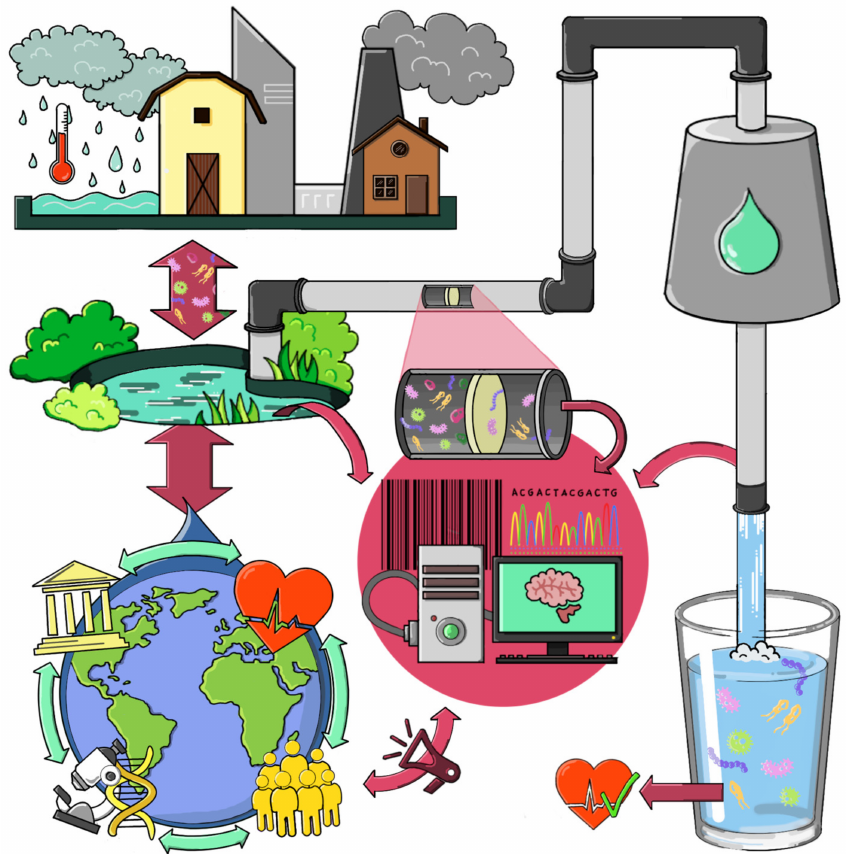
Figure 2. The journey of drinking water source and its microbial communities across drinking water treatment and distribution can be deciphered through omic approaches. Drinking water quality can be preserved and improved thanks to microbiome-based research, and this has multiple effects on human wellbeing, society, science, and the Earth as a whole. Bi-directional arrows highlight the mutual effect and the relations of